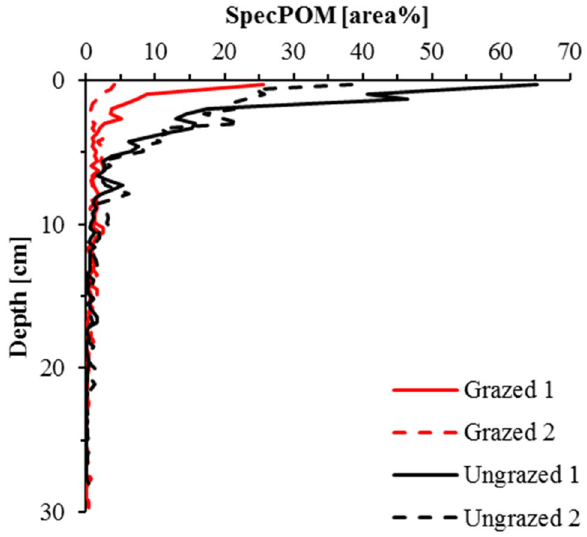
Figure 6. Linewise fractional cover of the SpecPOM for two grazed and two ungrazed soil profiles (summed fractional cover for 10 image